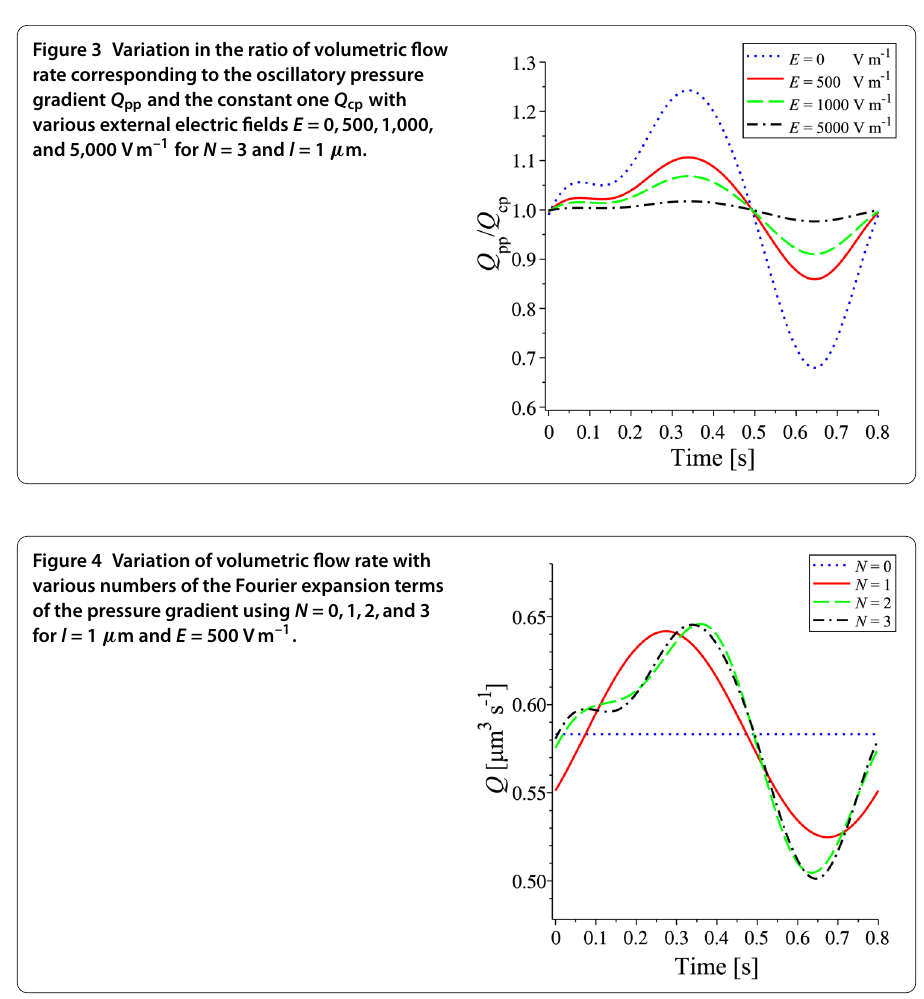
Figure 3 Variation in the ratio of volumetric flow rate corresponding to the oscillatory pressure gradient Q pp and the constant one Q cp with various external electric fields E = 0,500,1,000, and 5,000 Vm –1 for N = 3 and l = 1 μ m.